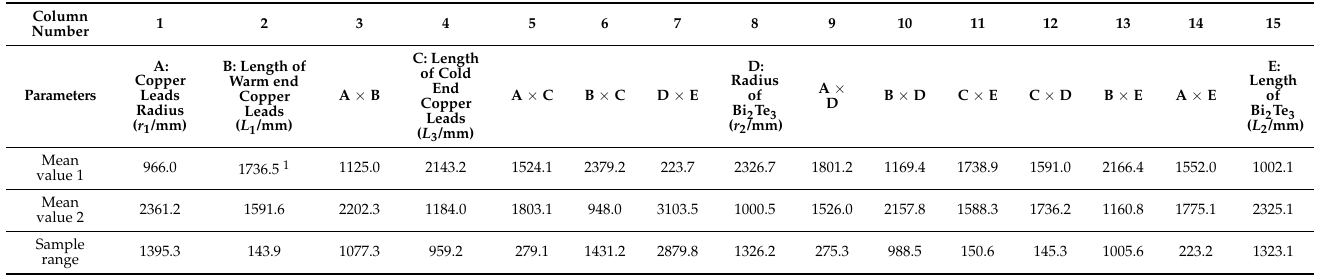
Table 2. Orthogonal experimental results of 120 A PCLs.